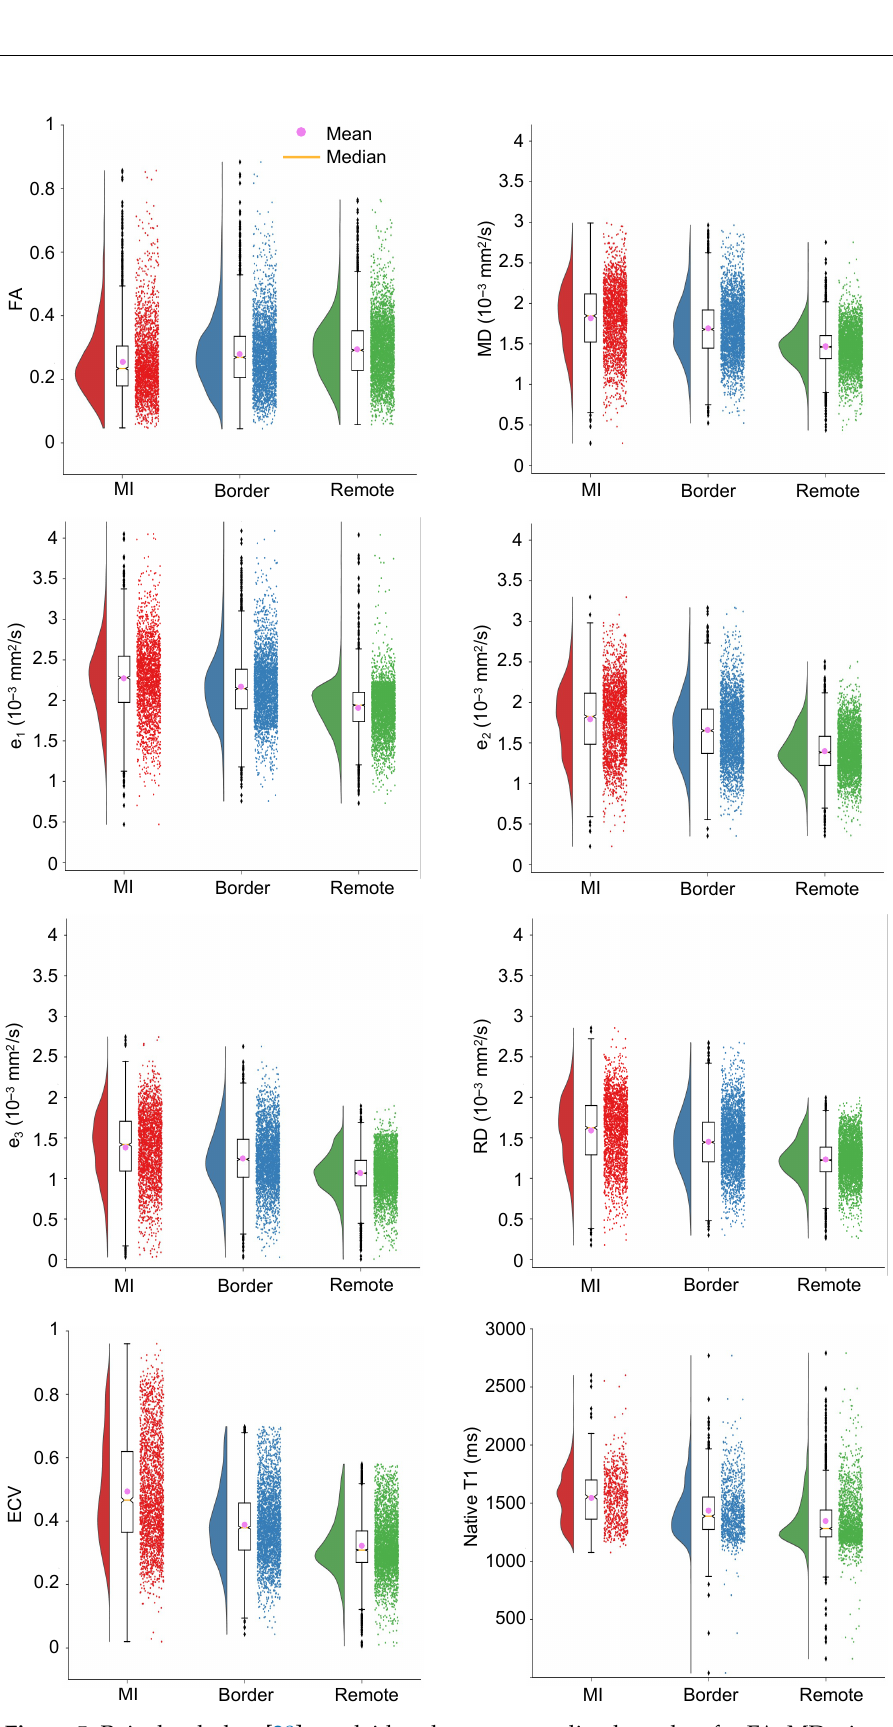
Figure 5. Raincloud plots [28] overlaid to the corresponding box plots for FA, MD, eigenvalues e 1 , e 2 , and e 3 , radial diffusivity (RD), extracellular volume fraction (ECV), and native T1 in the infarct, border, and remote myocardial